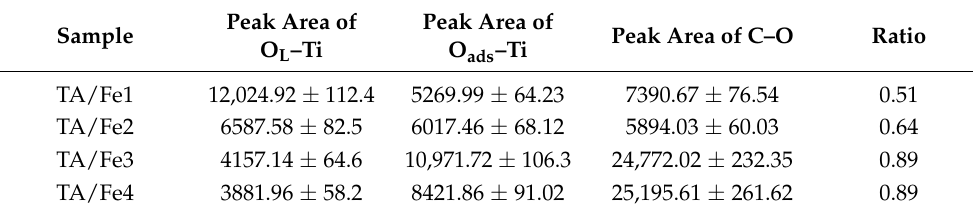
Figure 7. O 1s XPS spectra of the titanium oxide ‐ based aerogel catalysts doped by different Fe sources: ( a ) TA/Fe1, ( b ) TA/Fe2, ( c ) TA/Fe3, ( d ) TA/Fe4. Table 2. XPS peak areas of O 1s